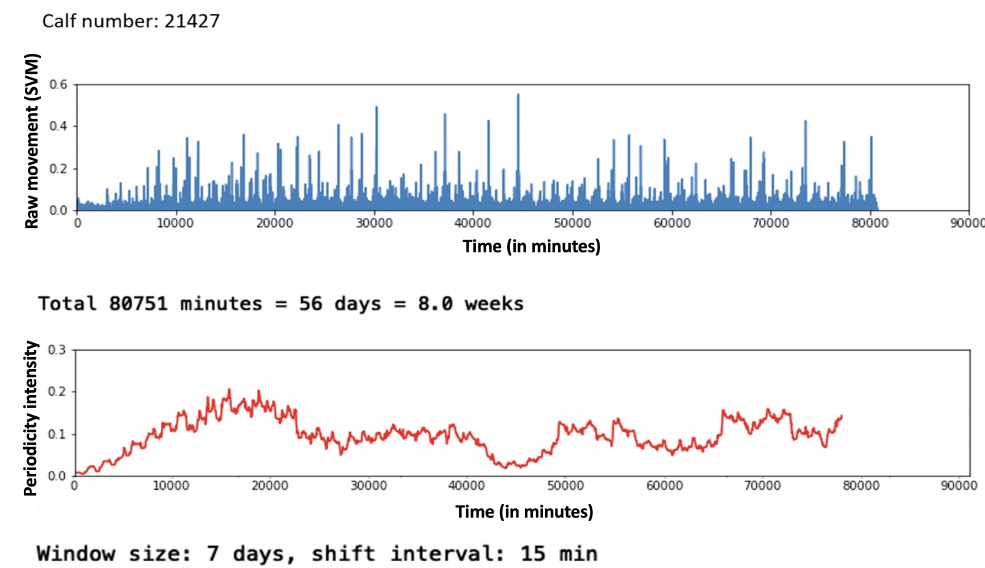
Figure 3. Raw data and periodicity intensity for calf 21427. The top graph shows the SVM values computed from raw x–y–z accelerometer data as one value per minute. Peaks throughout the logging period correspond to calf activity during the day and examining raw values of activity levels suggests a reasonably regular circadian rhythm for this calf. The bottom graph shows a time series of 24 h periodicity intensities, each value calculated from a 7-day period and the calculation is repeated every 15 min. This graph reveals a completely different picture for calf 21477 with a gradual acclimatisation to regular circadian rhythms for the first 14 days (c 19,000 min) followed by a drop-off reaching a low at approximately 31 days (c. 45,000 min) and then gradually recovering.